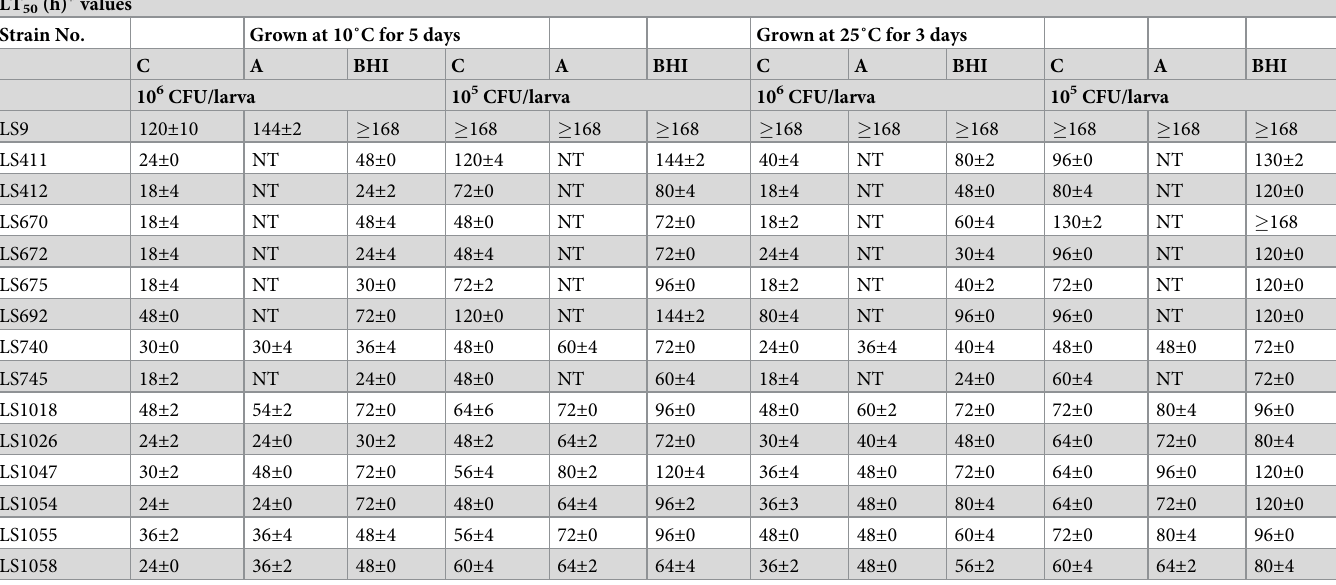
Table 2. LT 50 values of different L . monocytogenes and L . innocua (LS9) strains grown on cantaloupe fragments (C), apple fragments (A) and BHI at 10˚C and 25˚C. LT 50 (h) � values Strain